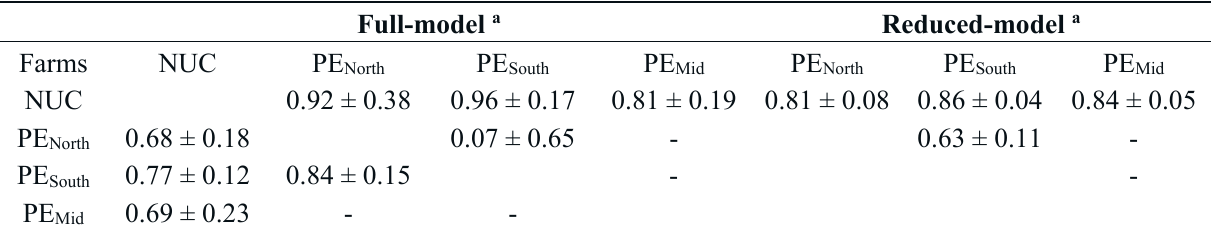
Table 3. Estimates of genetic (above diagonal) and common environmental correlations (below diagonal for full-model) for body weight (BW) in Atlantic cod. Estimates ± s.e. Full-model a Reduced-model a Farms NUC PE PE PE PE PE PE North South Mid North South Mid NUC 0.92 ± 0.38 0.96 ± 0.17 0.81 ± 0.19 0.81 ± 0.08 0.86 ± 0.04 0.84 ± 0.05 PE 0.68 ± 0.18 0.07 ± 0.65 - 0.63 ± 0.11 - North PE 0.77 ± 0.12 0.84 ± 0.15 - - South PE 0.69 ± 0.23 - - Mid a Animal mixed model with (full-model) or without (reduced-model) environmental effects common to full-sibs in trivariate and bivariate settings for the data from YC 2007 (NUC, PE North and PE South ) and YC 2010 (NUC and PE Mid ),